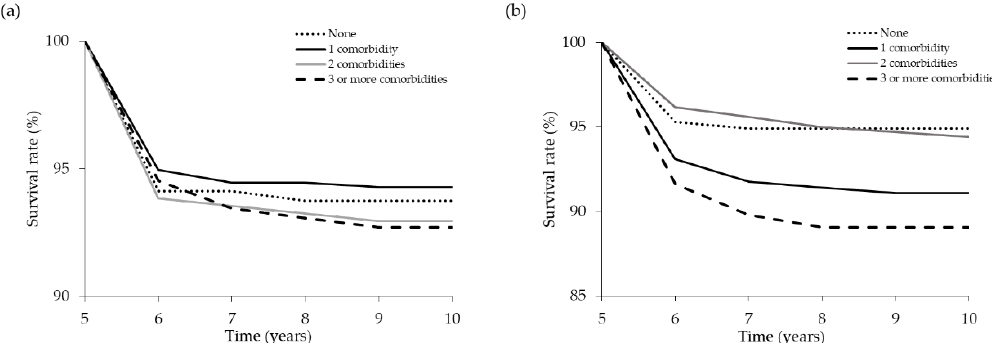
Figure 1. Kaplan – Meier plots showing cumulative patient ( a ) and renal ( b ) survival by comorbidity